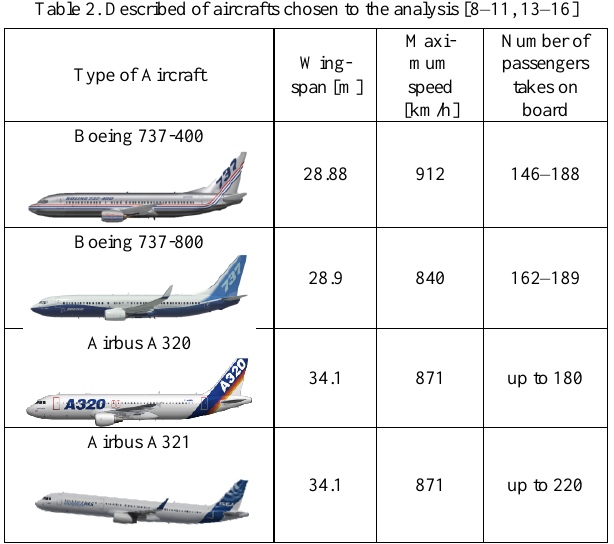
Table 2. Described of aircrafts chosen to the analysis [8–11, 13–16]